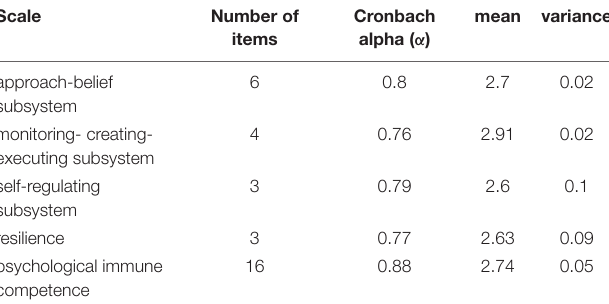
TABLE 1 | Reliability measures of the psychological immune system inventory subscales.